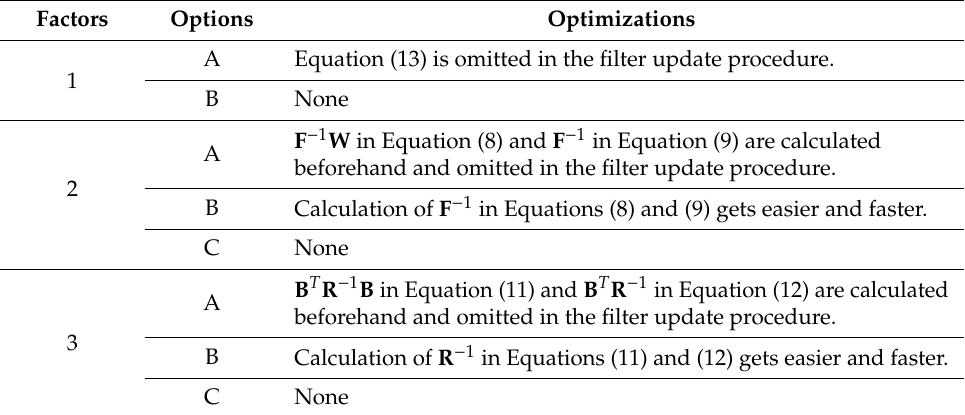
Table 2. Optimization of the information filter (IF) using di ff erent factor options. Factors and options are from Table 1. Optimizations are summarized from previous discussion about each factor in Section